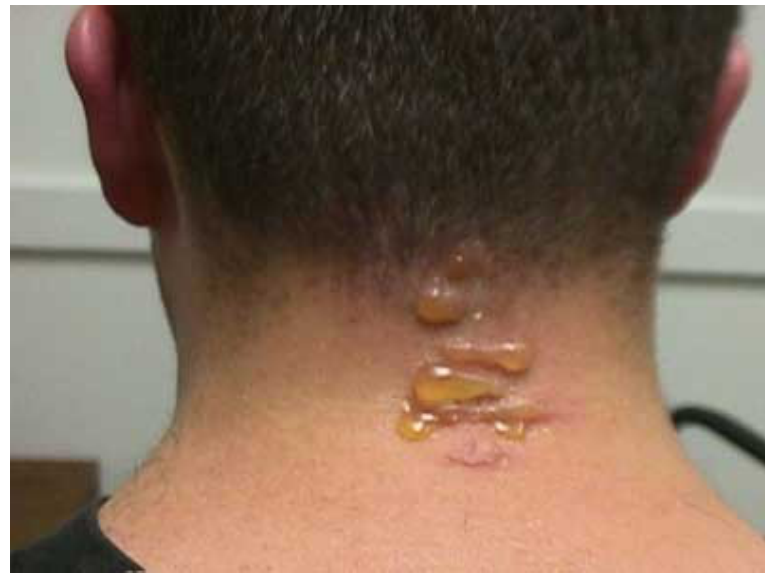
Figure 4. Blistering symptom provoked by a meloid